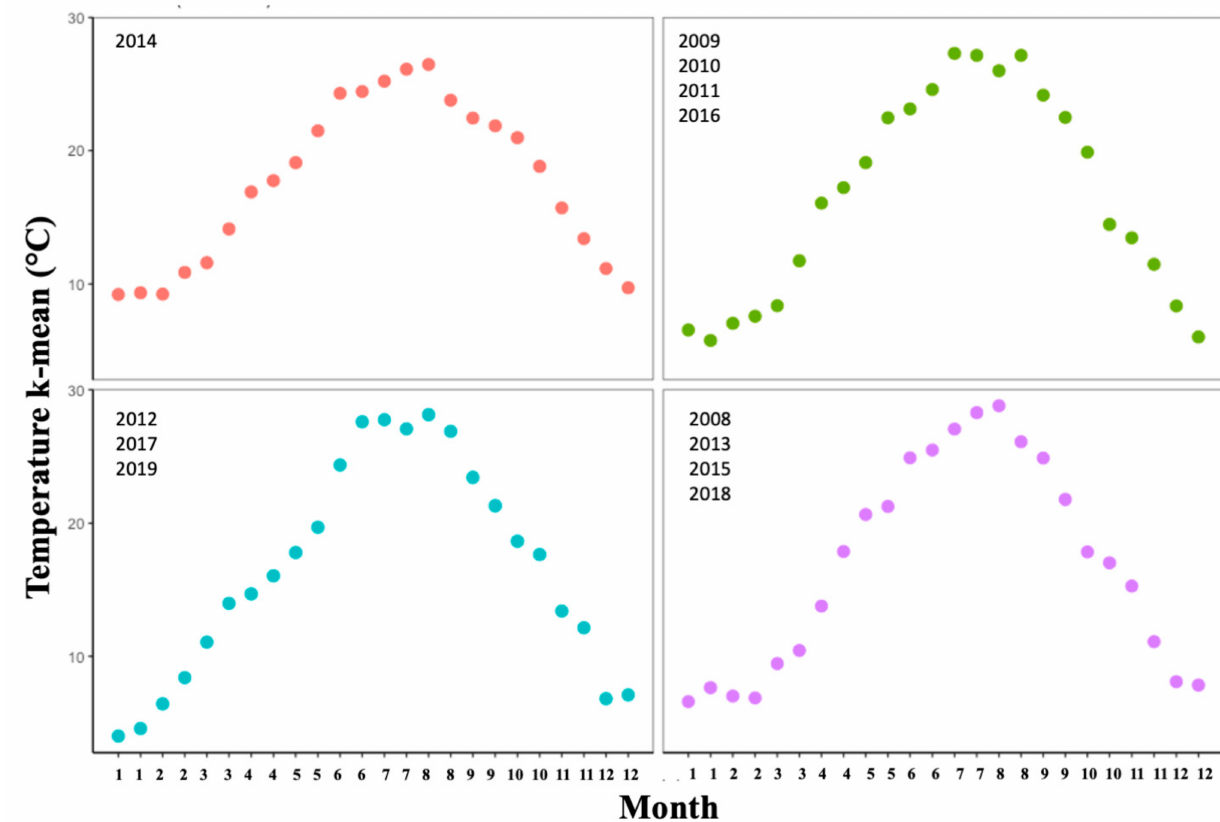
Figure 2. K-means clustering results, showing values of centroids for temperature for each fortnight for each cluster. Years belonging to each cluster are displayed in the top left corner of each